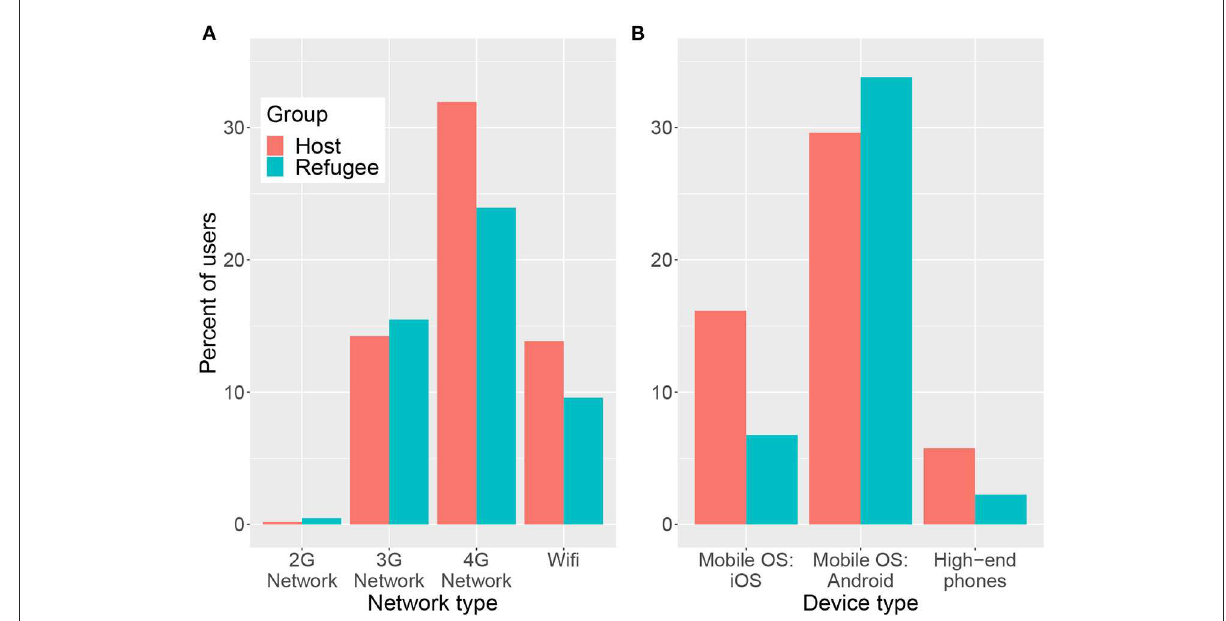
FIGURE4 Percentage of Facebook users aged 13+ from the host and refugee communities in Lebanon using various network connections (A) and device types (B) to access the platform. Note that the percentages across the different network connections or device types may not add to 100% as users may be using other means to access Facebook such as a cable internet connection, other mobile operating systems or a desktop computer.